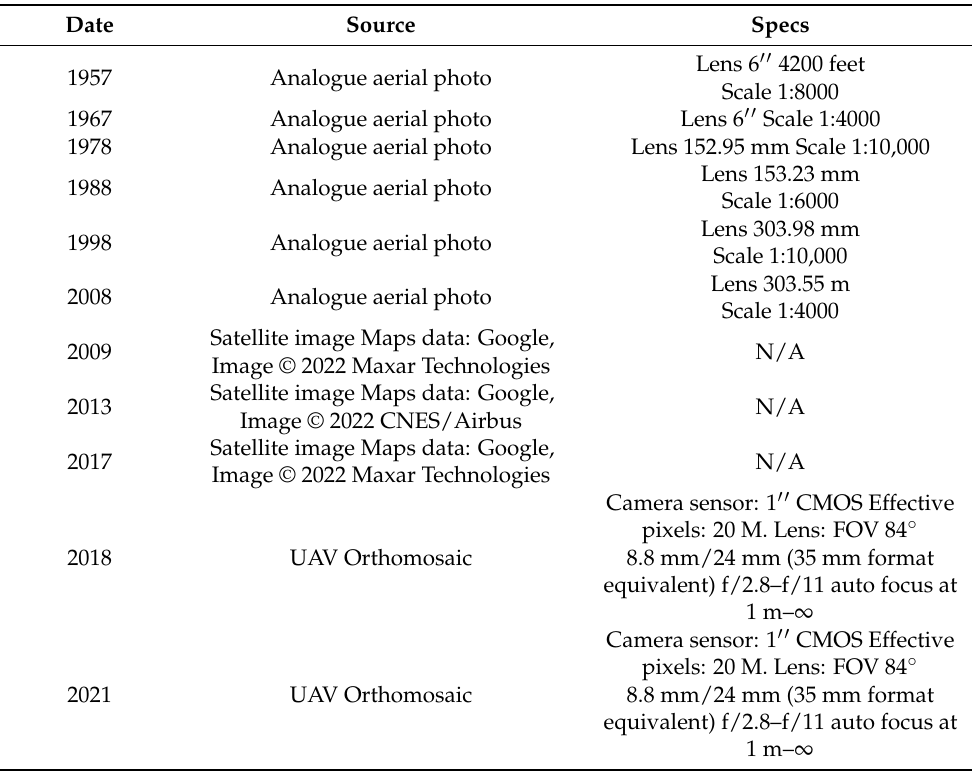
Table 1. Summary table with image information used in this